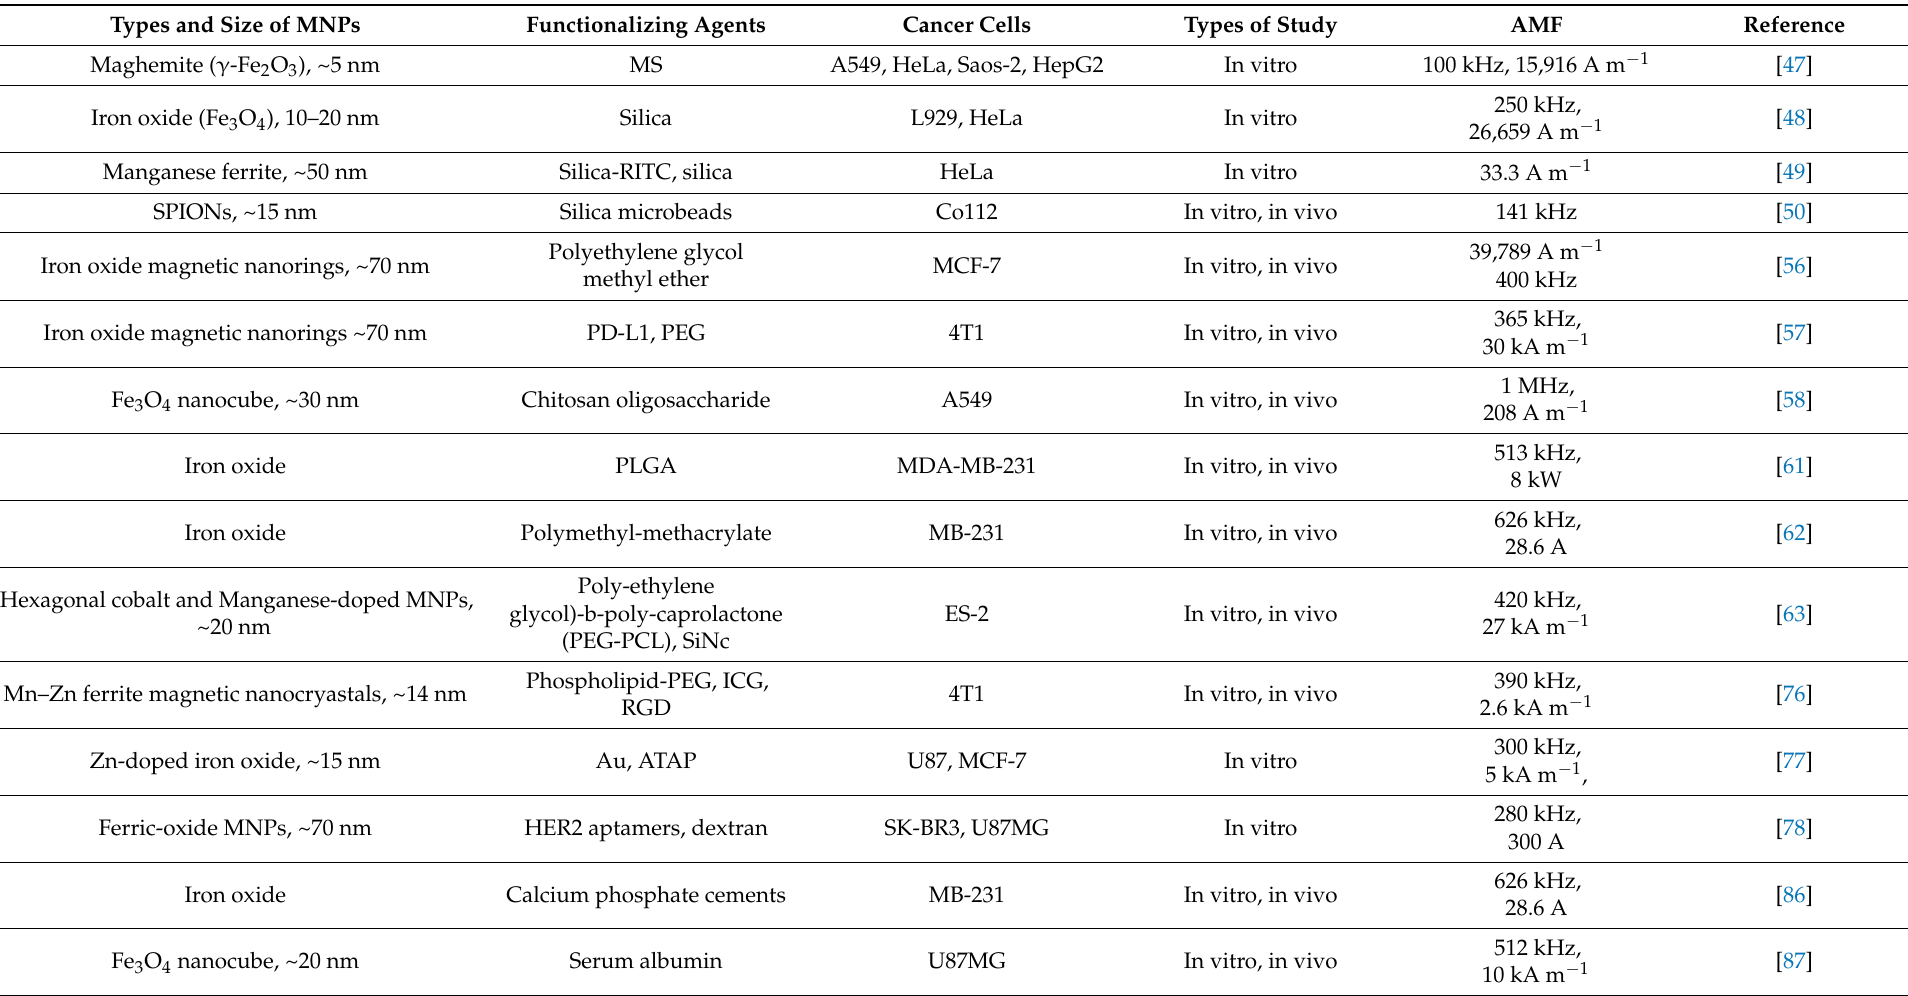
Table 1. Summary of the use of functionalized MNPs for AMF-induced cancer